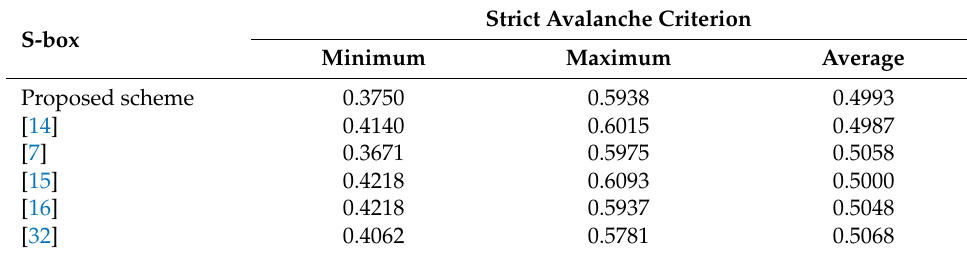
Table 5. Comparison of strict avalanche criterion.